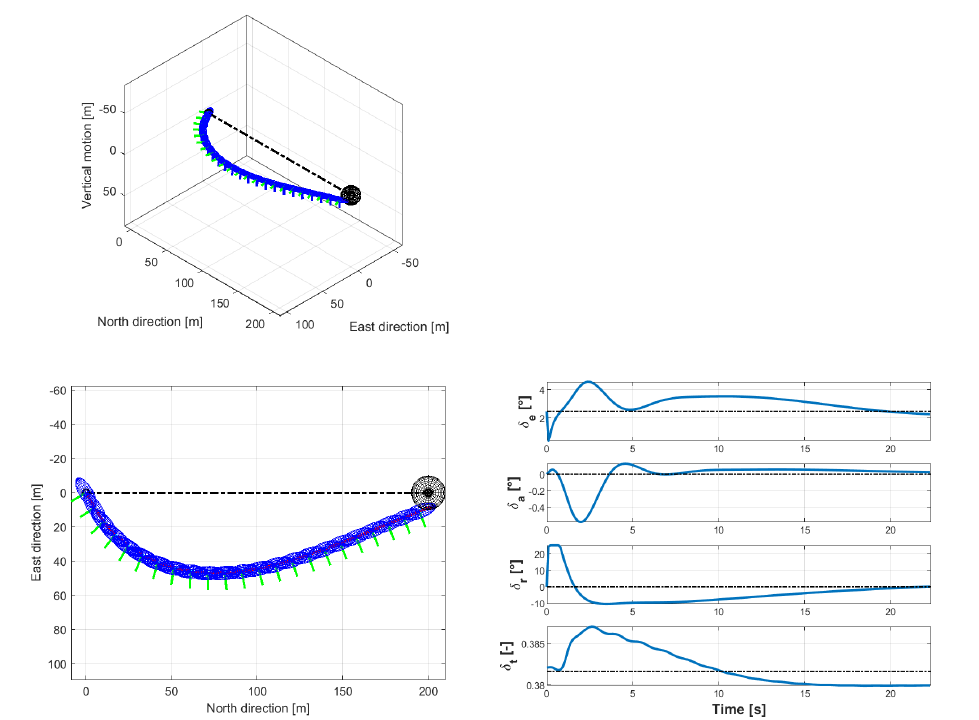
Figure 13. Trajectory and control behavior for an initial misalignment ∆ ψ 0 = 60 degree with respect to a horizontal track, as flown by the stabilized baseline airship with the proposed guidance control system, at 10 m/s of ground speed. ( Top-left ) three-quarter view of the 3D trajectory from the northeast. ( Bottom-left ) view of the trajectory from the top. Black dash-dotted lines: target track. Black spheres: target checkpoint capture volume. ( Bottom-right ) time histories of controls. Black dash-dotted lines: trimmed